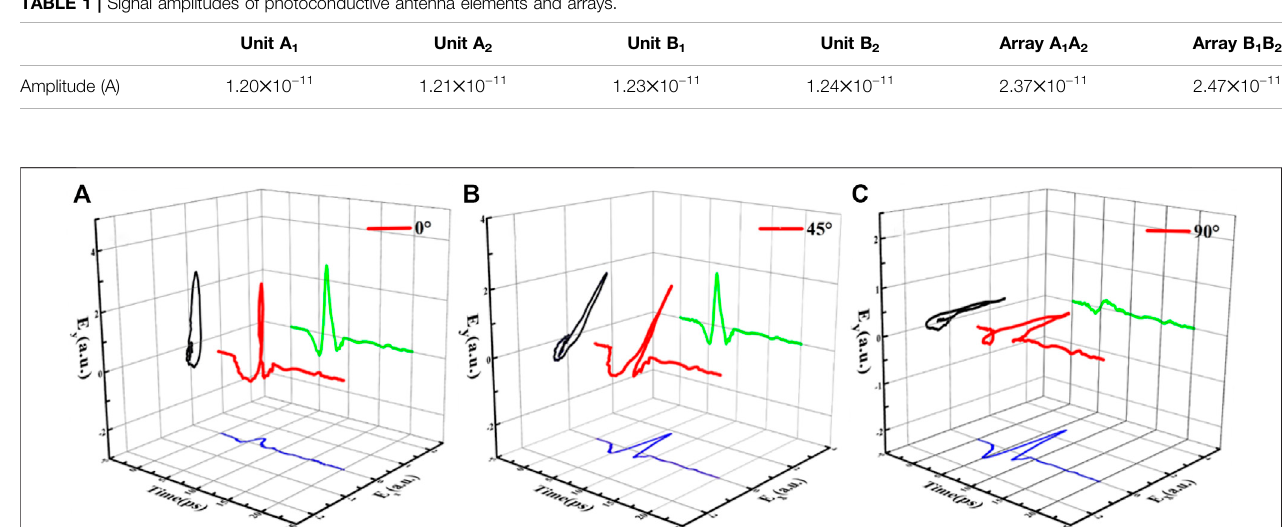
Frontiers in Physics |